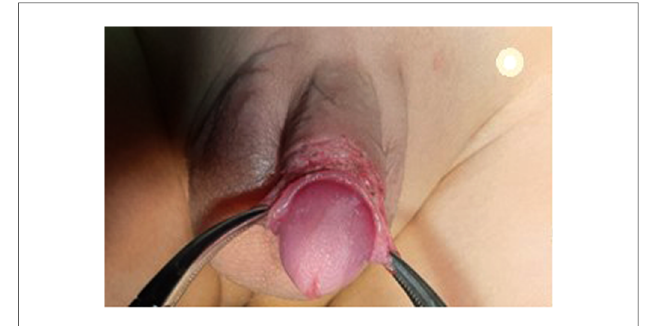
FIGURE 3 Two retracting mosquitos were applied at the sub-coronal level at 3 and 9 o ’ clock to pull the penis